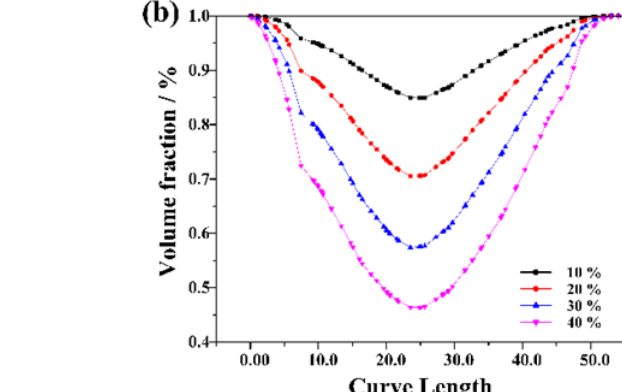
Figure 8. Volume distribution characteristics of tar vapor in the radial direction of the cyclone. ( a ) The water content is 20% and ( b ) the inlet velocity is 8.0 m/s.